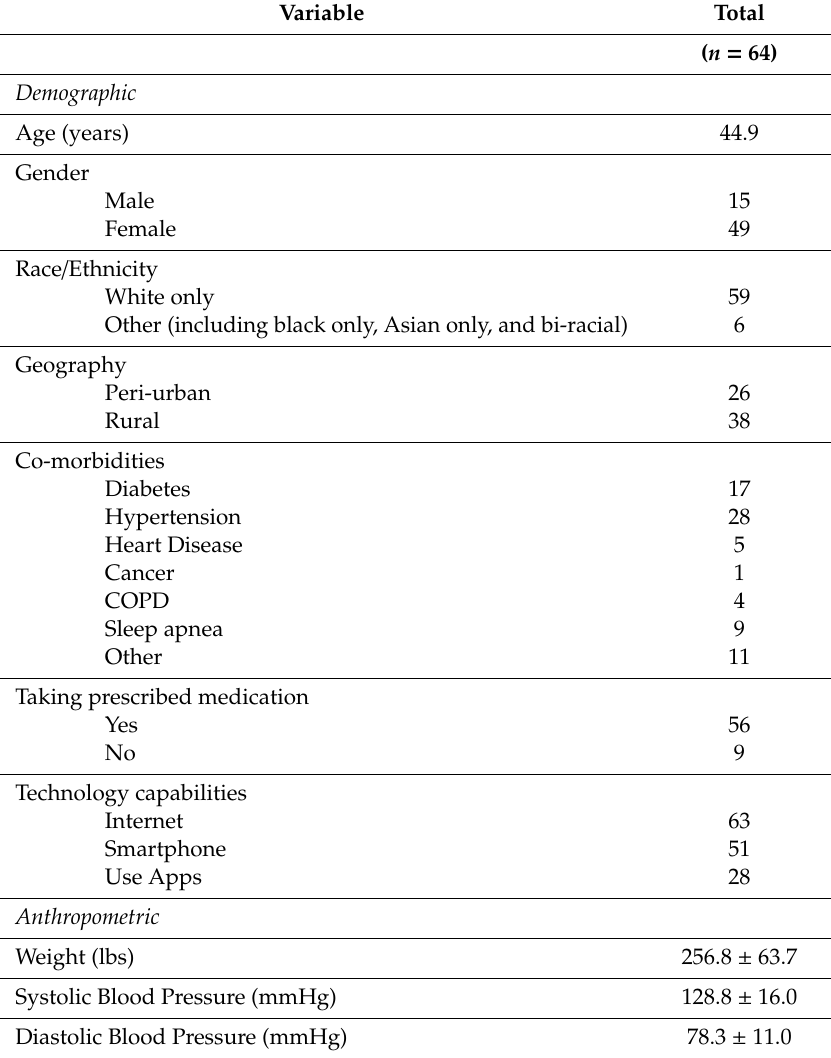
Table 1. Population